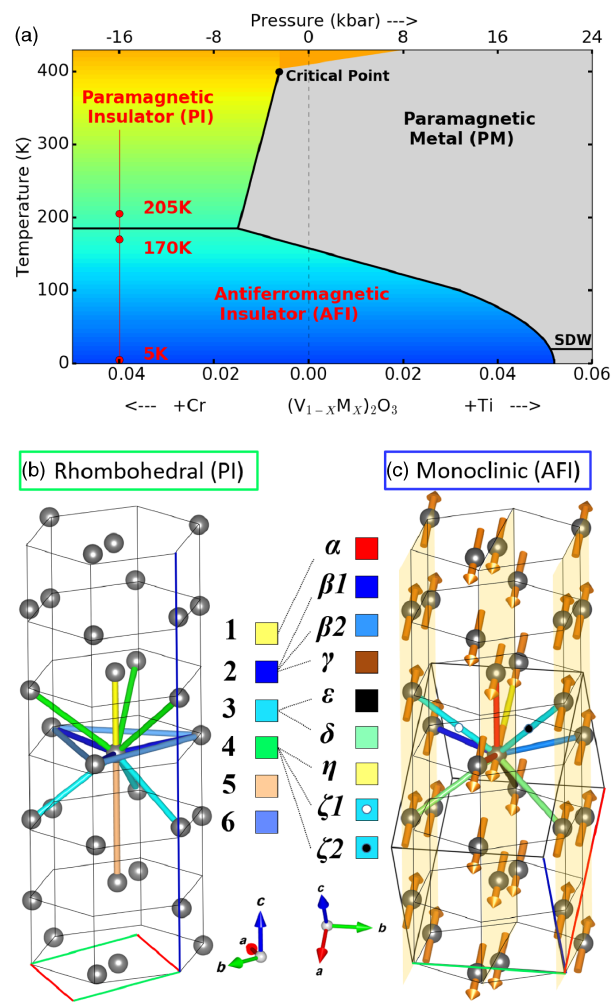
FIG. 1. (a) V 2 O 3 phase diagram showing the extent of the AFI, PI, and PM phases [14] as a function of both chemical substitution (bottom axis) and the equivalent applied pressure (top axis). (b) The rhombohedral structure of the PI phase, with the color-labeled exchange interactions (1 – 6) determined in the paper. Black hexagons outline the pseudohexagonal (corundum) unit cell. (c) The distorted crystal structure (monoclinic unit cell shown) and magnetic structure in the AFI phase [15], where the magnetic moments are ferromagnetically aligned in monoclinic a þ c planes, which are then stacked antiferromagnetically along the monoclinic b axis. Greek indices indicate the updated nearest- neighbor bond configuration resulting from the monoclinic distortion. Oxygen atoms are omitted for